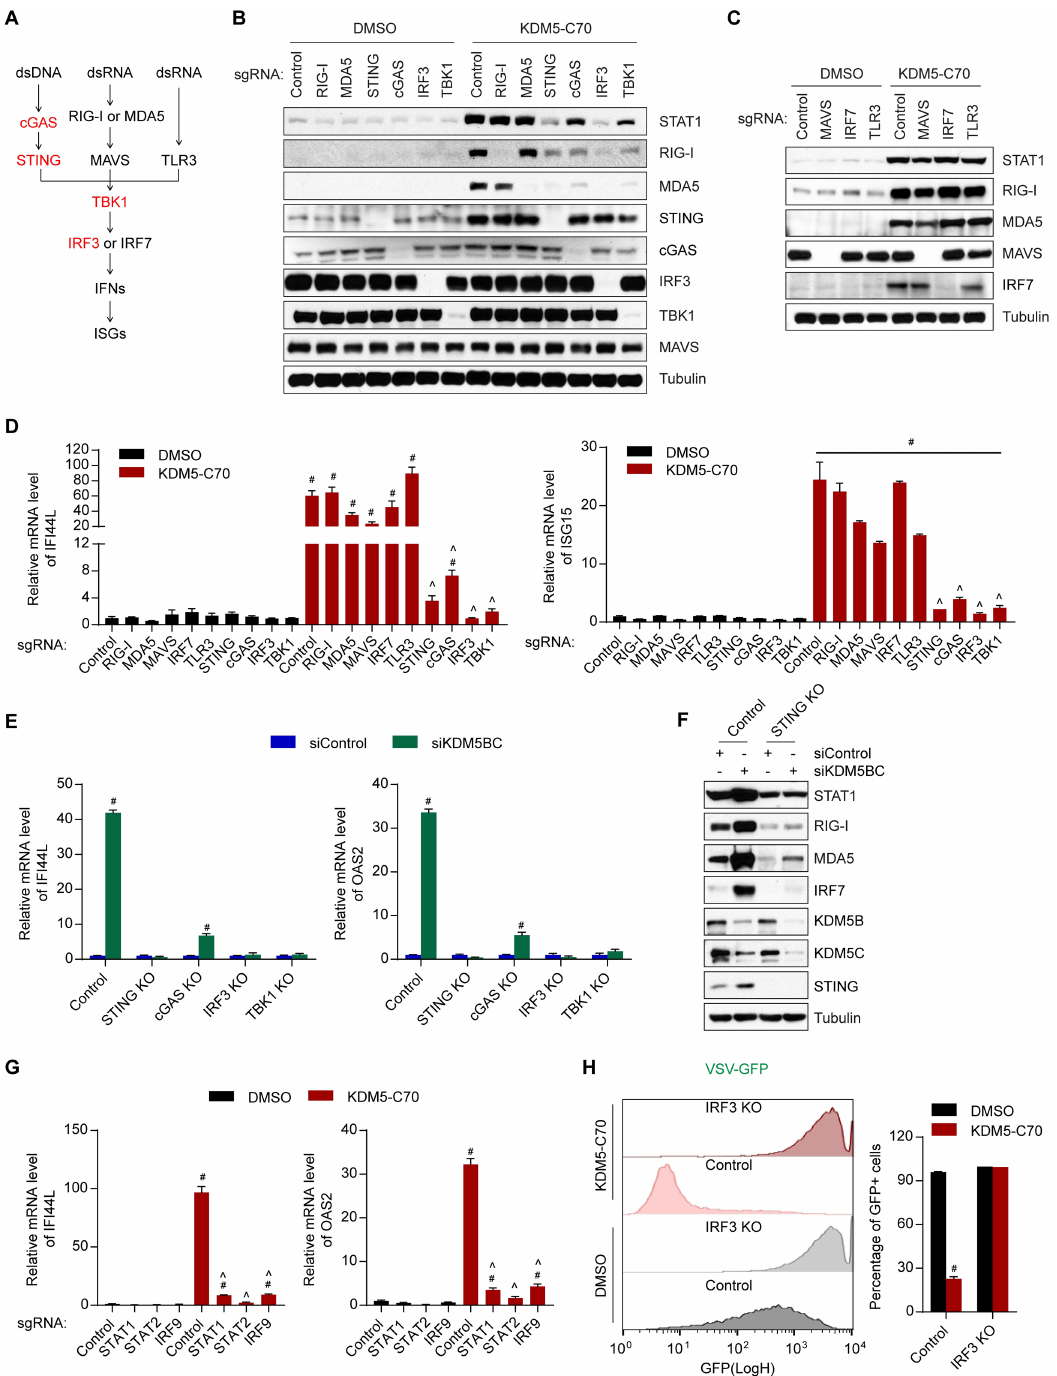
Fig 3. Activation of ISGs by KDM5 inhibition is dependent on the cGAS-STING-TBK1-IRF3 signaling pathway. (A) Schematic of the pattern recognition receptor pathways. (B–D) Western blot (panel B and C) and RT-qPCR (panel D) analyses of MCF7 cells with knockout of the indicated genes after treatment with DMSO or 1 μM KDM5-C70 for 6 days. (E, F) RT-qPCR (panel E) and western blot (panel F) analyses of MCF7 cells with knockout of the indicated genes 5 days after transfection with the indicated siRNAs. (G) RT-qPCR analysis of MCF7 cells with knockout of the indicated genes after treatment with DMSO or 1 μM KDM5-C70 for 6 days. (H) Flow cytometry plots (left panel) and quantification of percentage of GFP-positive cells (right panel) in the indicated MCF7 knockout cells 24 hours after infection with VSV-GFP virus at MOI 0.5. Error bar denotes SEM. Representative data from triplicate experiments are shown in panel D, E, and G. Three biological replicates are shown in panel H. # p < 0.01 for